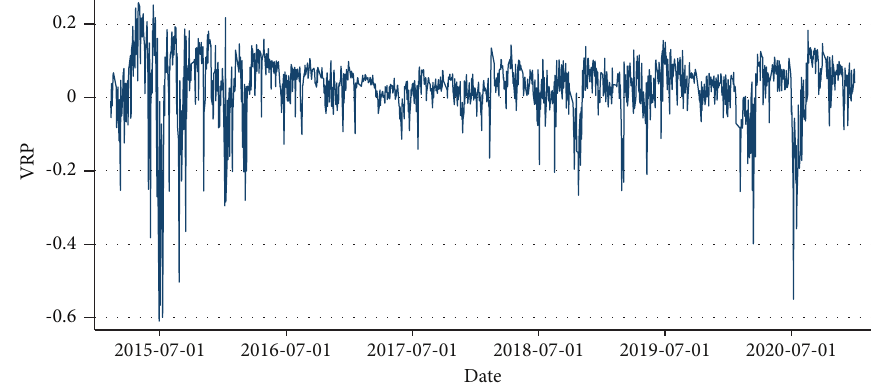
Figure 3: VRP original data chart of SSE 50ETF